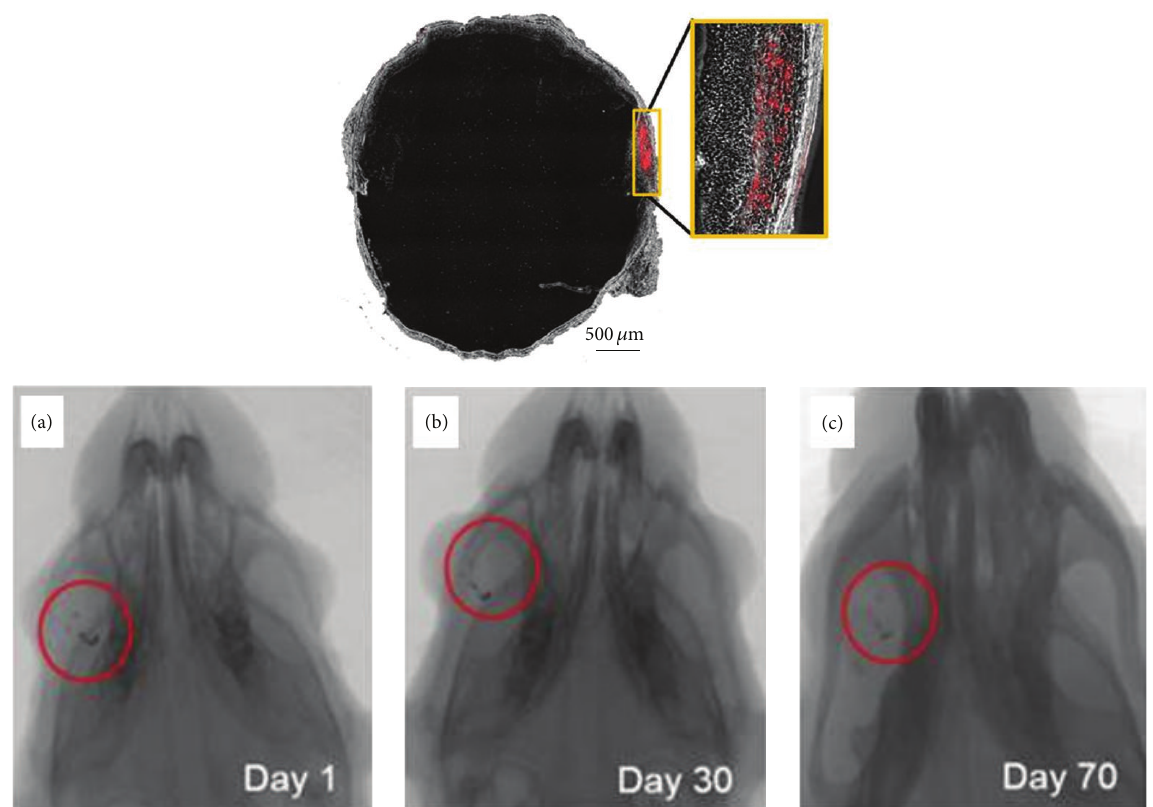
Figure 4: Tracking of injected human Wharton’s jelly-derived MSCs in an RP rat model (Royal College of Surgeons rats) with microcomputed tomography. Microcomputed tomography images show localization of gold-loaded human Wharton’s jelly-derived MSCs in the right eye (a) on day one. The cells were found to be retained in the eye without further migration at day thirty (b) and day seventy (c) after transplantation. PKH 26 (labelled red) indicated the subretinal site of human Wharton’s jelly-derived MSCs after cell transplantation at week two. Modified with permission from Creative Commons Attribution License